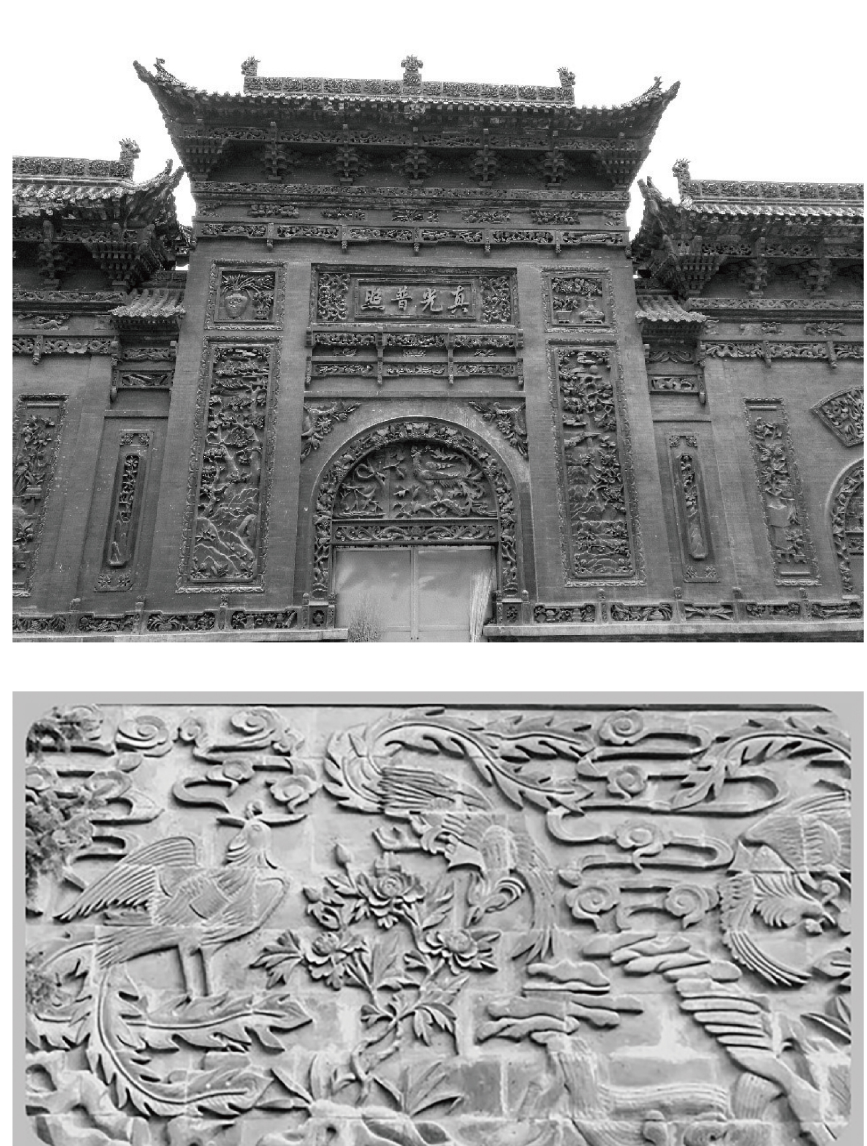
Figure 8. Brick Carving of Two Sufi Shrines in Qinghai province (Photo by Zhou Chuanbin, 2017). Upper: the brick carving gate of Shanghezhong Qubbah dedicated to a Qadriyyah Sufi master Yang Baoyuan (1780–1873), on which one can see trees, flowers, and phoenixes. Under: This is part of the screen wall titled “One Hundred Phoenixes”, with a peony in the center, in Machangyuan Qubbah. Perhaps it is because the Shrine is dedicated to a female Sufi master that made the designer to put so many phoenixes around one peony (both phoenix and peony can be a female symbol in